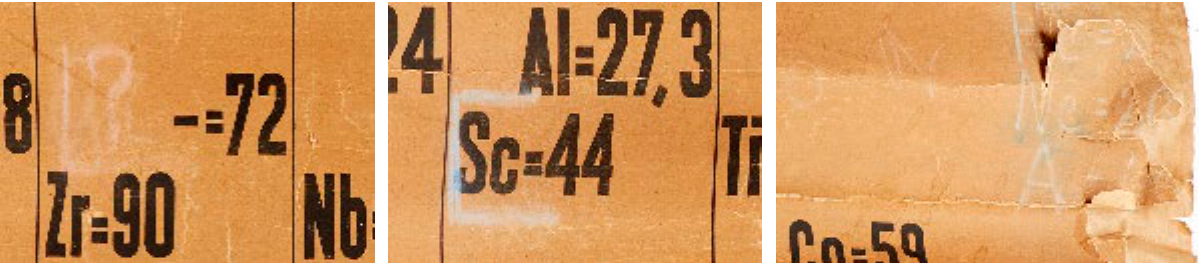
Figure 10. Close-up views of the St Andrews wallchart table showing chalk markings. R. Alan Aitken,